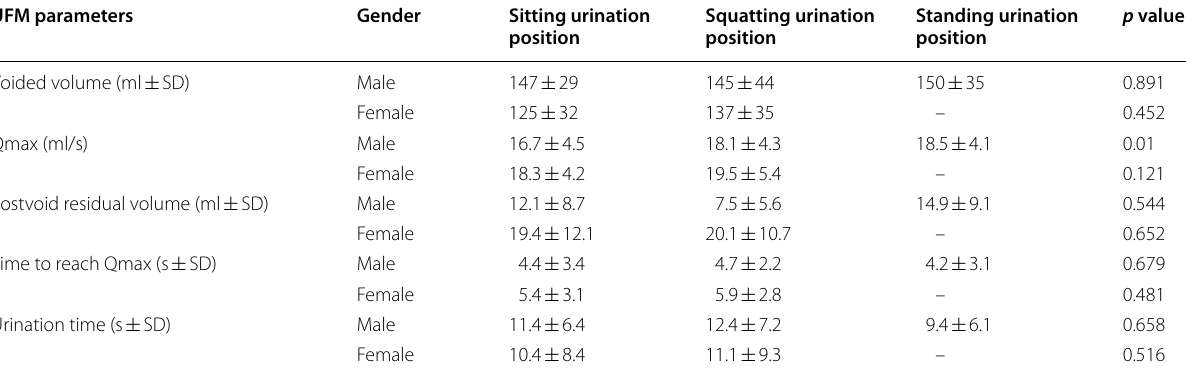
Table 2 Uroflowmetry parameters recorded in group 2 (consisted of healthy males and females) in three different urination